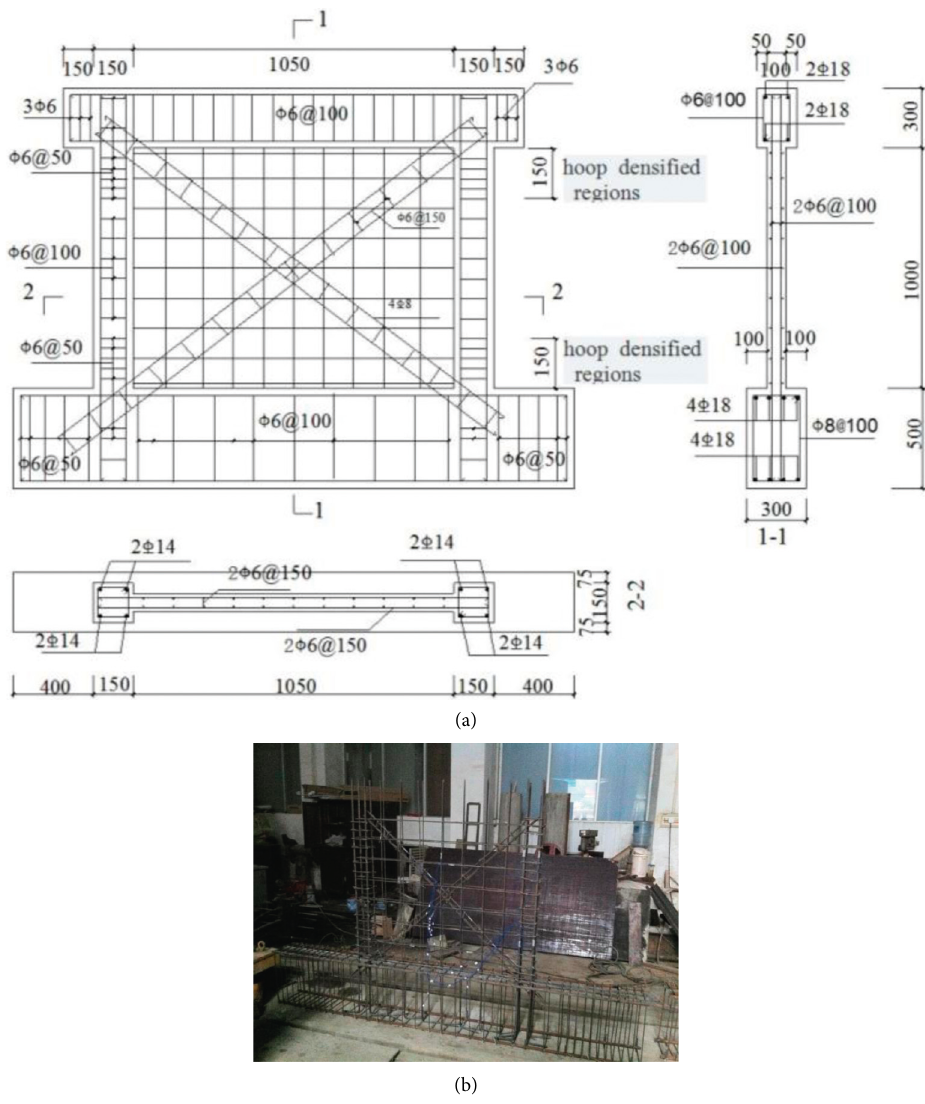
Figure 1: Reinforcement details and the actual model of HDLSW. (a) Reinforcement details of HDLSW. (b) Actual model of